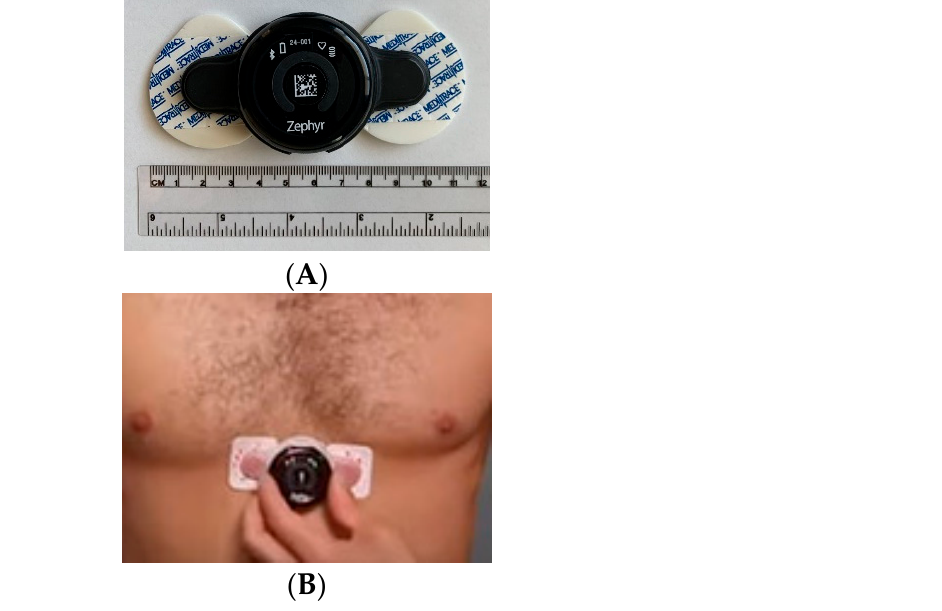
Figure 1. Image of the sensor and ECG pads ( A ) adhered to the patient’s chest over the xiphoid process ( B ).